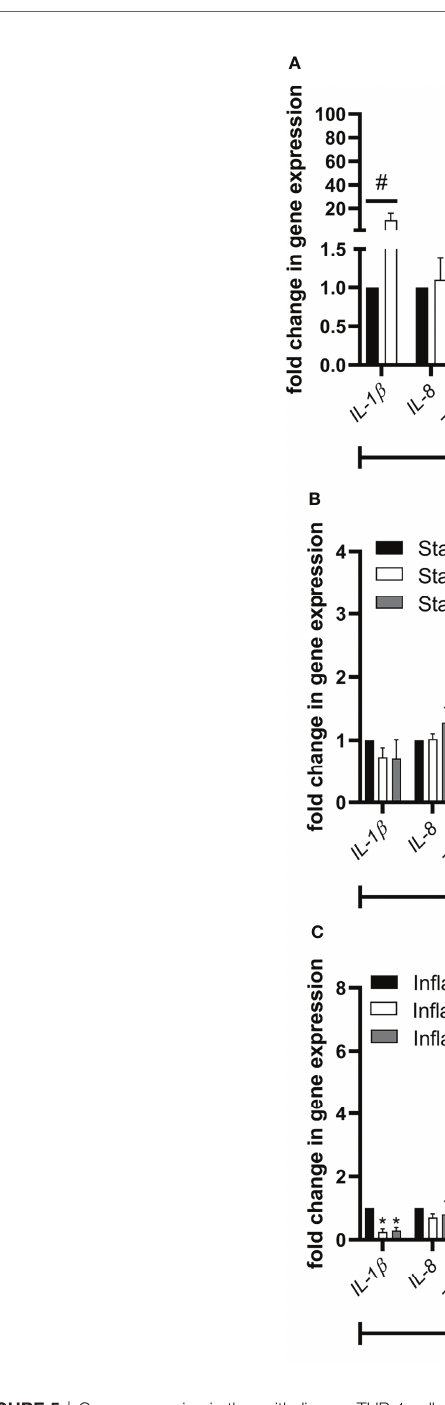
FIGURE 5 | Gene expression in the epithelium or THP-1 cells after 48 h of triple culture. (A) Gene expression in the in fl amed WT culture compared to the stable WT culture. (B) Gene expression in the stable knockout cultures compared to the stable WT culture. (C) Gene expression in the in fl amed knockout cultures compared to the in fl amed WT culture. Mean ± SD of N = 3. # p < 0.05, compared to the stable control; *p < 0.05, compared to the WT